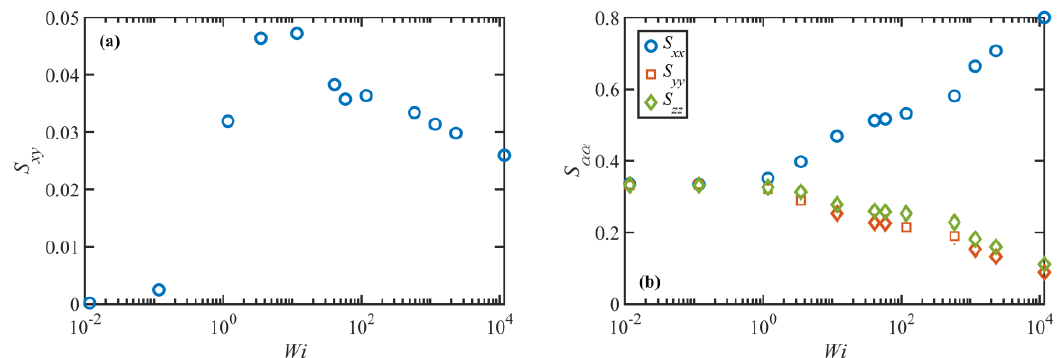
Figure 6. The S xy ( a ) and diagonal ( b ) components of the tube segmental orientation tensor S , as functions of Wi at steady state, as obtained from the NEMD data for the C 1000 H 2002 melt.